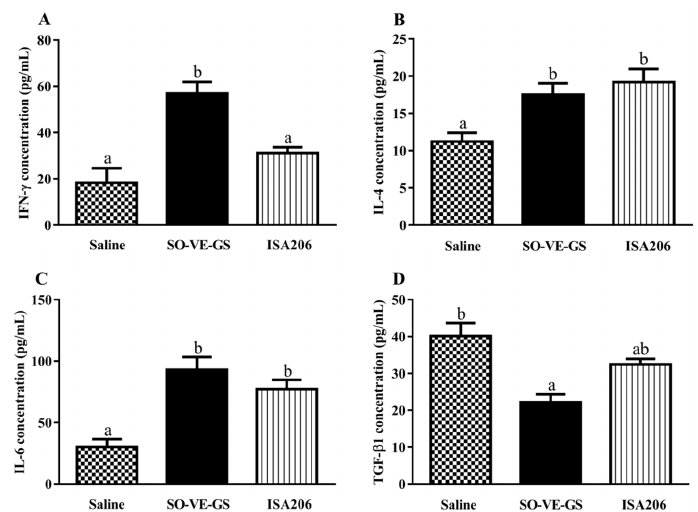
Figure 4. Cytokine production by splenocytes. Mice ( n = 6 / group) were i.m. immunized twice at a 2-week interval with the FMDV antigen in saline or adjuvanted with SO-VE-GS or ISA 206. Splenocytes were isolated from spleens harvested 2 weeks after the boost. The cells were co-cultured with an inactivated FMDV antigen (10 μ g / mL) for 72 h. The supernatants were used for analysis of IFN- γ ( A ), IL-4 ( B ), IL-6 ( C ), and TGF- β 1 ( D ) by ELISA kits. The values are presented as means ± SE. Bars with different letters are statistically different ( P < 0.05).